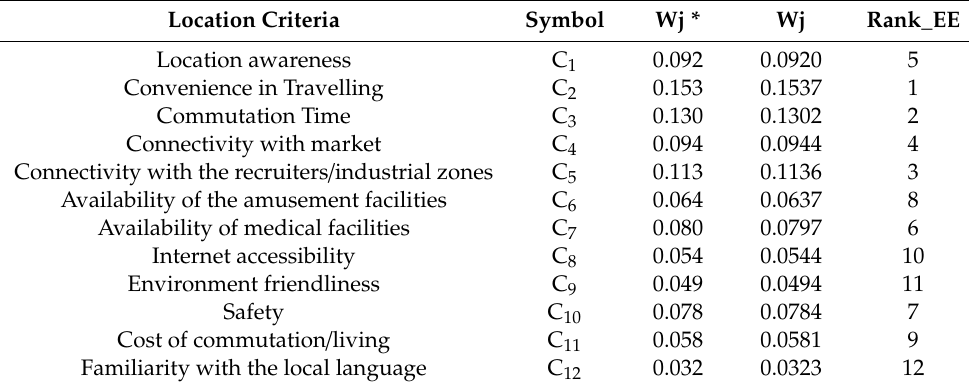
Table 14. Aggregate rank (EE panel).